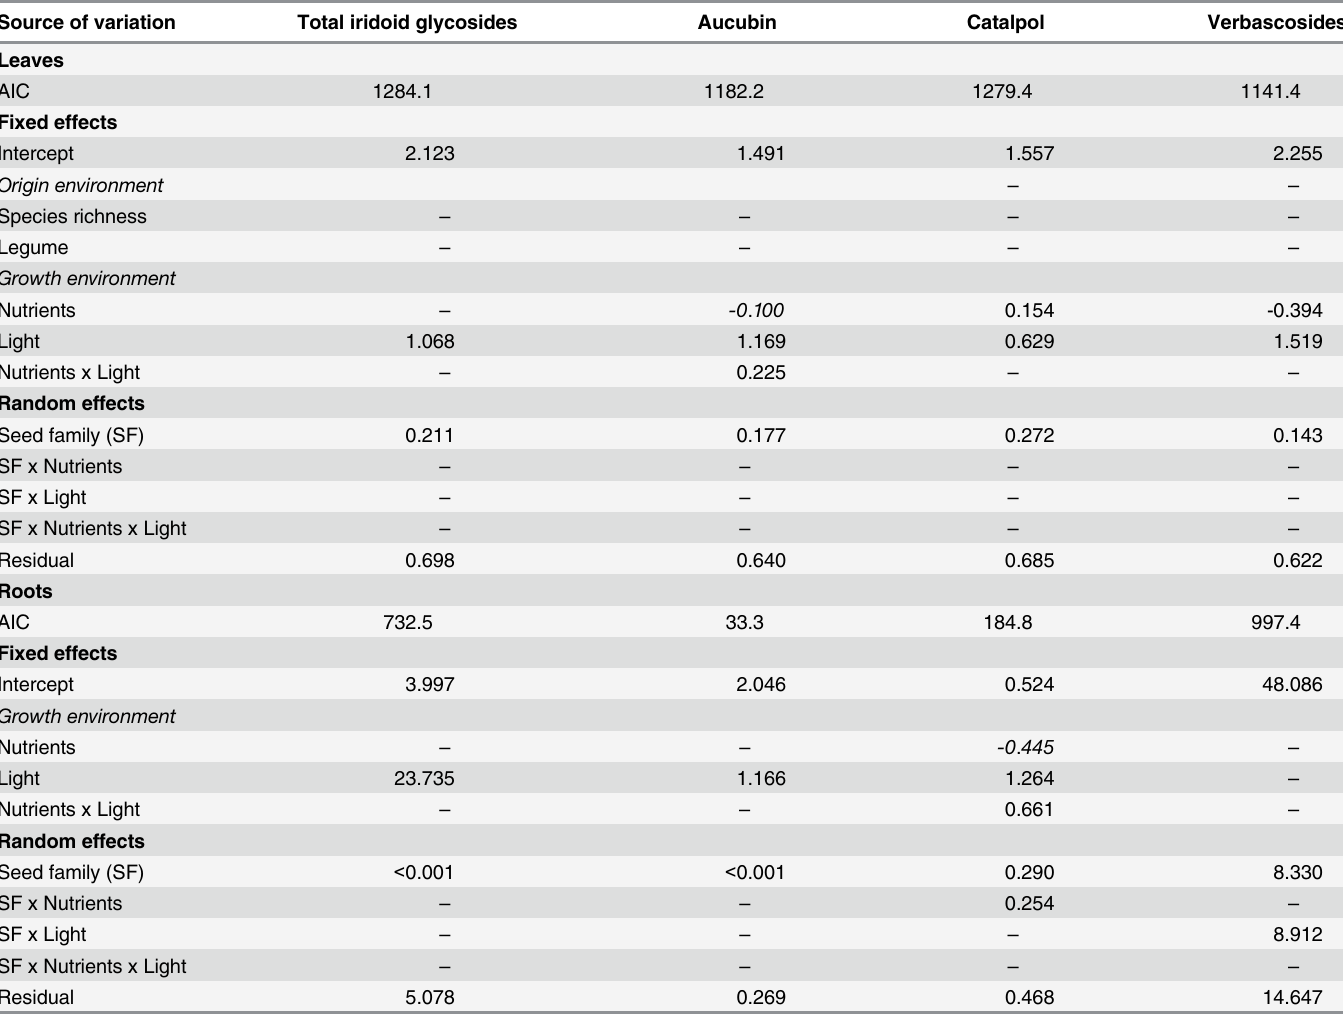
Table 1. Summary of mixed-effects model analyses of iridoid glycoside and verbascoside concentrations in leaves and roots of Plantago lanceo- lata . Plants were grown at two different levels of nutrient and light availability and originated from seed families collected in experimental communities of dif- ferent plant diversity. Root samples were analysed for offspring originating from three seed families taken from the monoculture and a 60-species mixture.